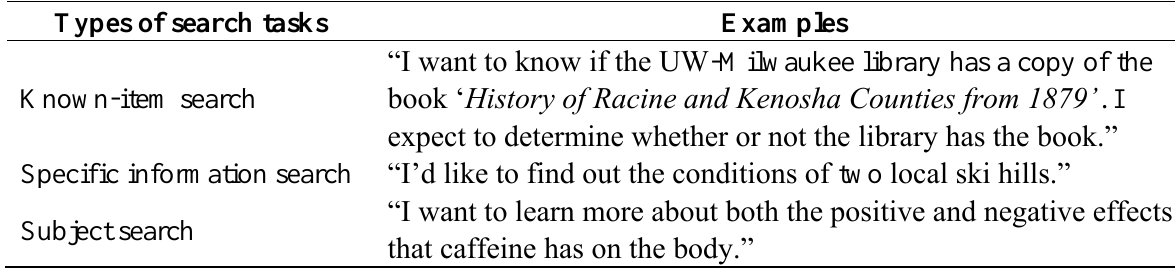
Table 2. Types of search tasks and